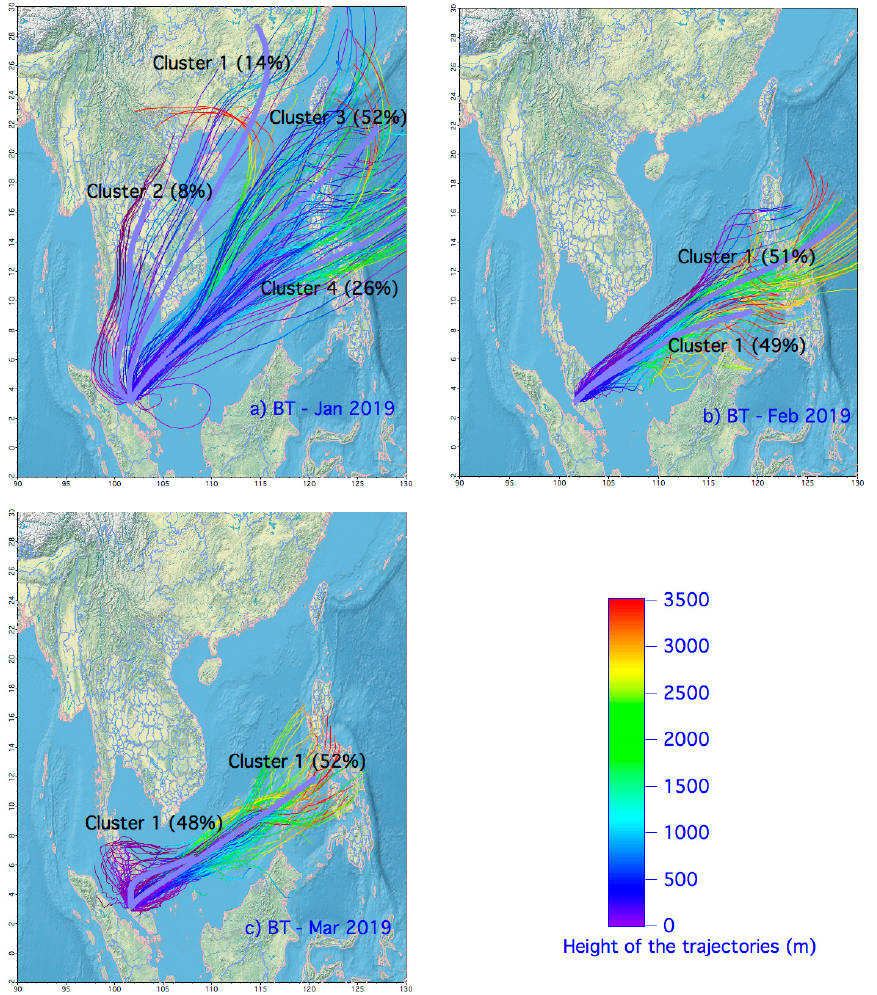
Figure 3. Cluster of backward trajectories (BT) using HYSPLIT model during January, February, and March in 2019. ( a ) BT-January 2019, ( b ) BT-February 2019, ( c ) BT-March 2019.